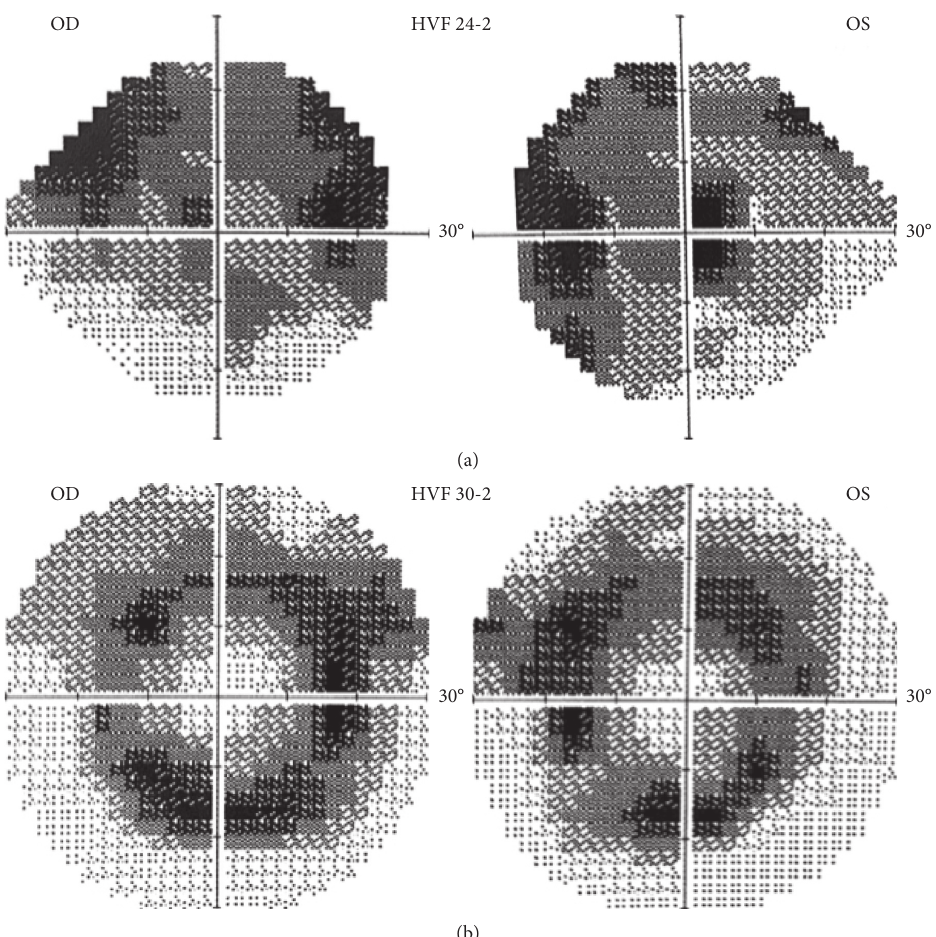
Figure 5: (a) A 30–2 protocol humphrey visual field of the patient that shows circular scotomas, corresponding to the midperipheral ring of hyperautofluorescence seen on UWF-FAF. (b) A 24–2 protocol humphrey visual field of the offspring showing largely superior scotomas OU, corresponding to atrophy seen on UWF-FAF and dropout of superficial capillary plexus seen on